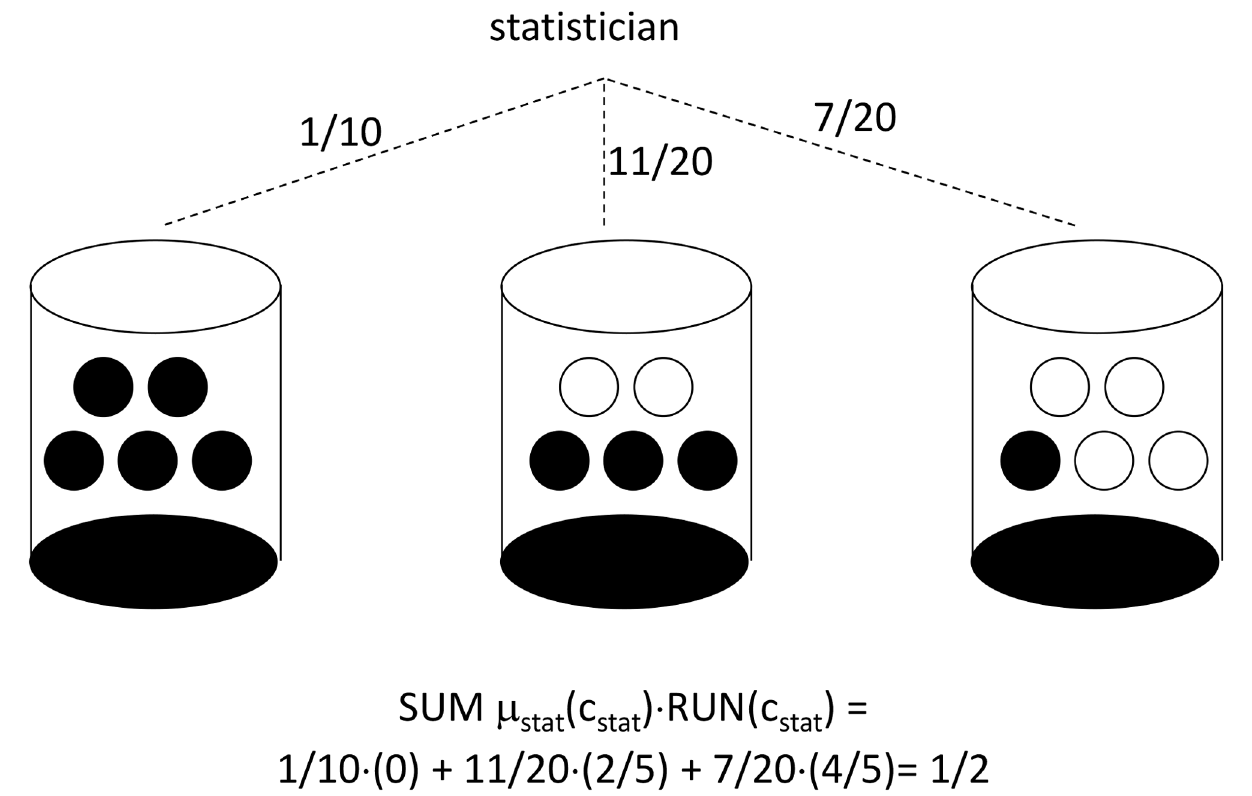
Fig 3. Urn Design for Run-Reversal Equilibrium with 5 Clinics. An urn is selected according to the probabilities shown, and then balls are drawn without replacement until the urn is empty. A run in treatment imbalance is assigned for a clinic when a white ball is drawn. A reversal in treatment imbalance is assigned for a clinic when a black ball is